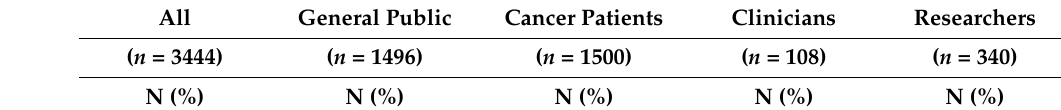
Table 2. Univariate logistic regression analysis of variables associated with intent to undergo BRCA1/2 testing.